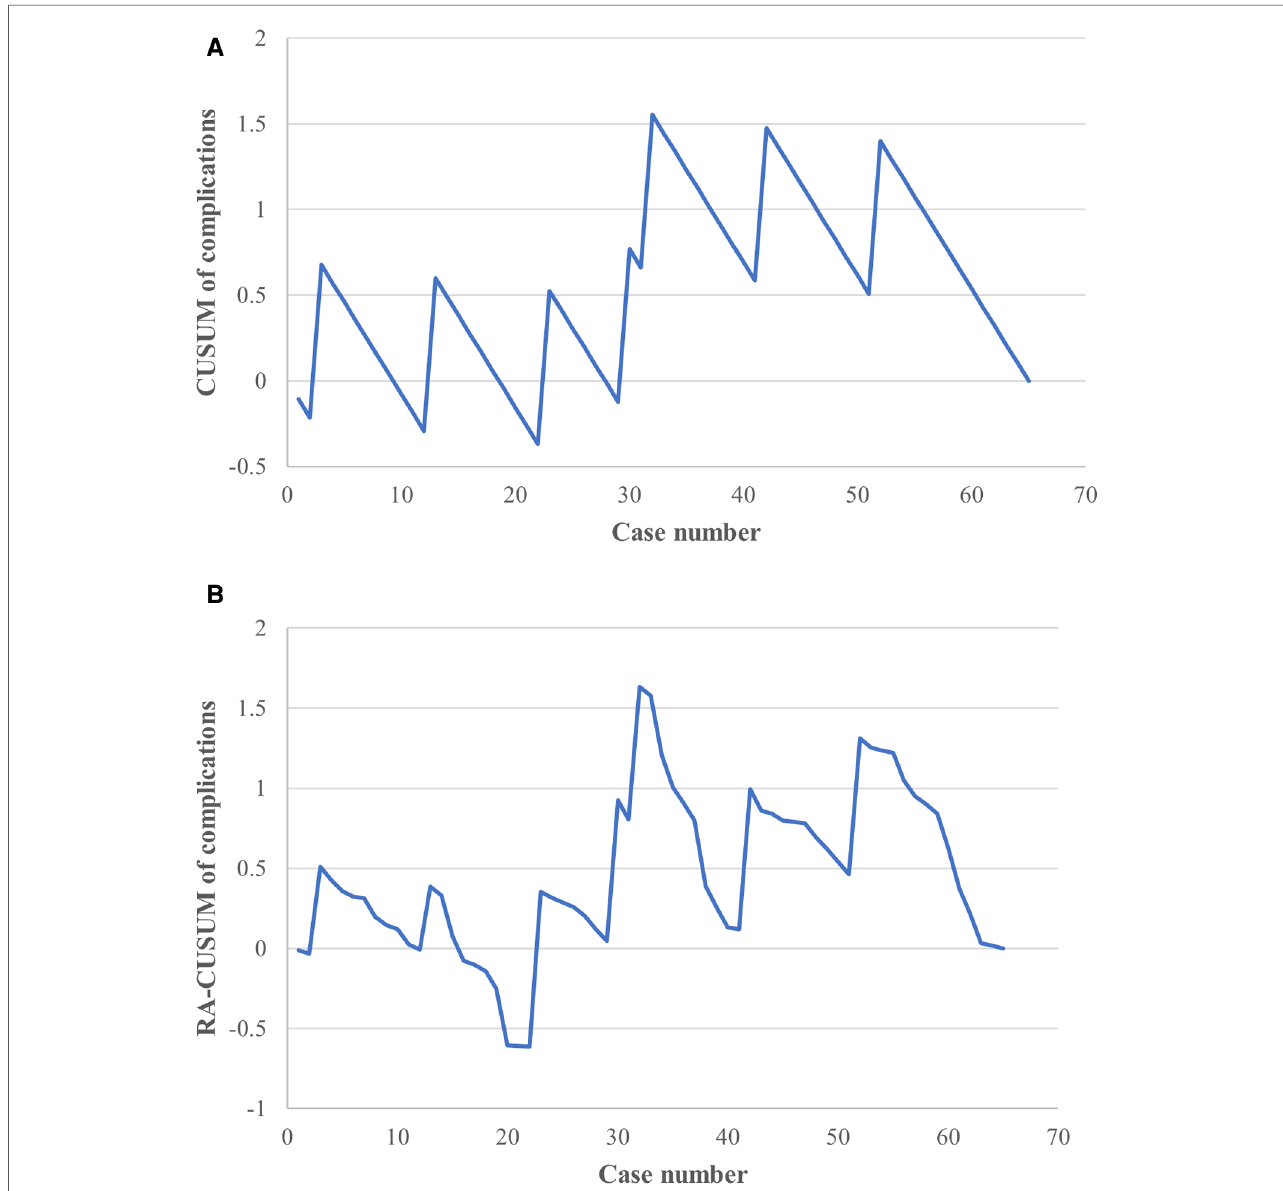
FIGURE 5 CUSUM and risk-adjusted CUSUM (RA-CUSUM) analysis for complications. ( A ) The CUSUM based on intraoperative/postoperative complications showed an acceptable fl uctuation during the learning phase. ( B ) Small fl uctuations were observed until the 22nd case, with a clear downward tendency seen after the 32nd case in the RA-CUSUM analysis.